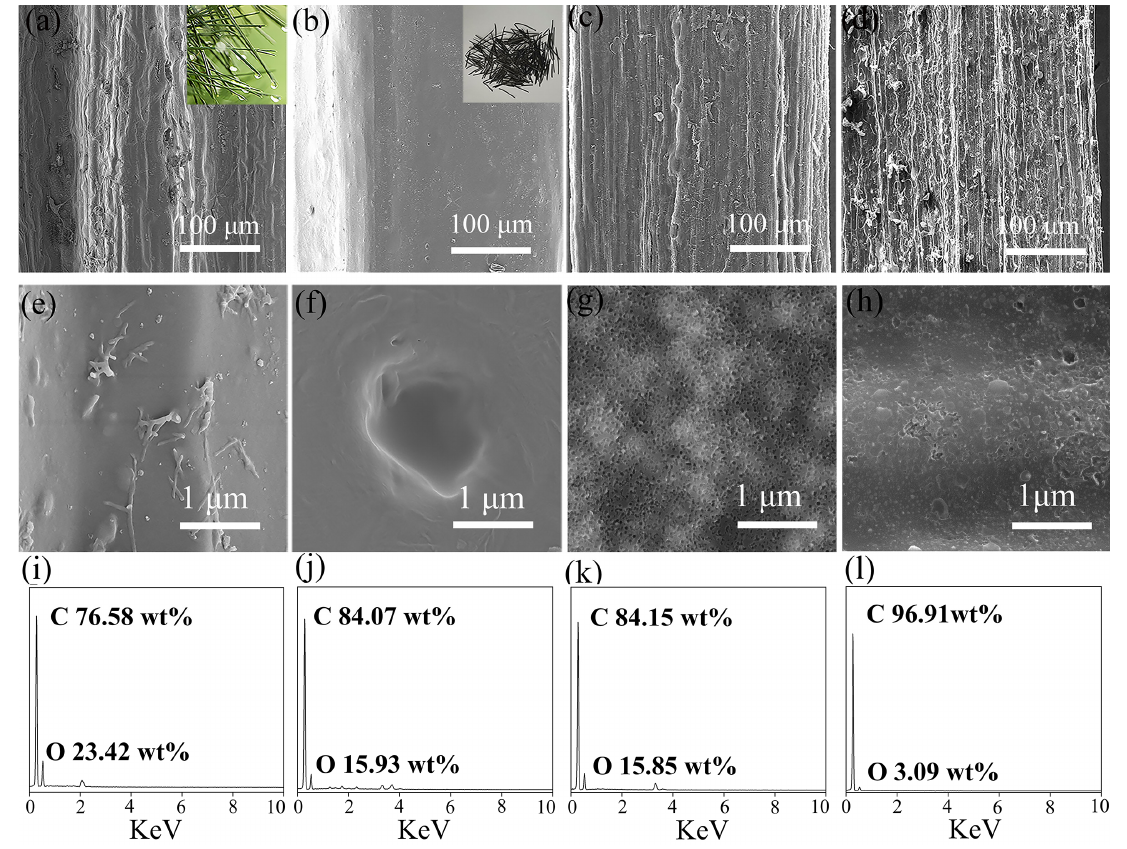
Figure 2. ( a , e , i ) SEM images and EDS spectrum of the original pine needles; ( b , f , j ) SEM images and EDS spectrum of PNCFs; ( c , g , k ) SEM images and EDS spectrum of the pore-rich PNCFs; and ( d , h , l ) SEM images and EDS spectrum of the pore-rich PNCFs@graphene. ( d , h , l ) SEM images and EDS spectrum of the pore-rich